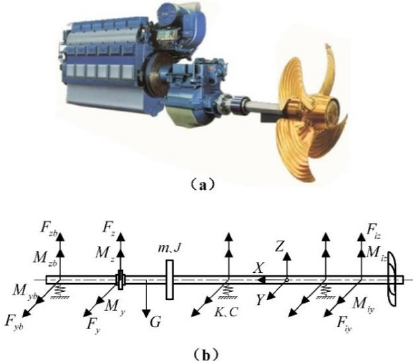
Figure 2. Configuration of ship power system. ( a ) The physical structure of propulsion shaft system. ( b ) The diagram model of GCRS.